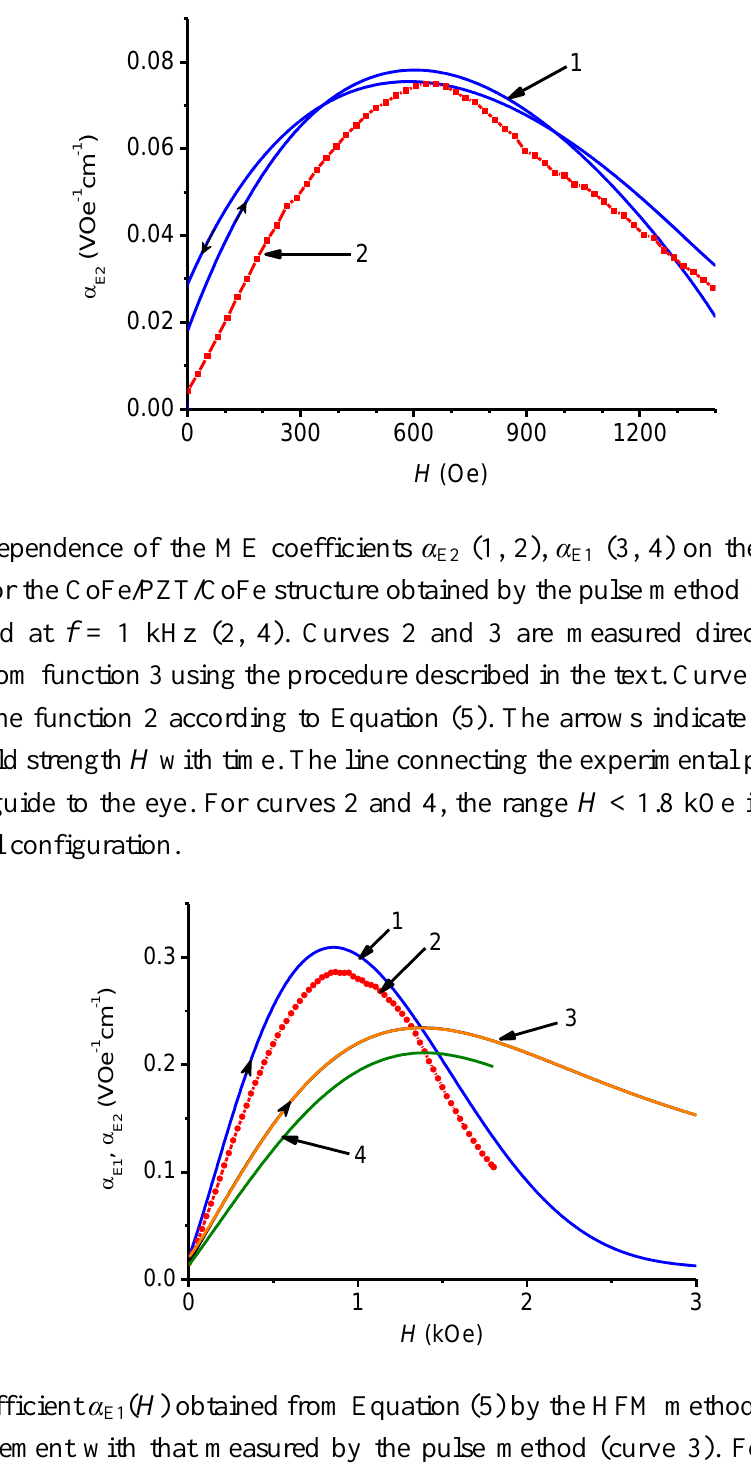
of the field strength H for the E2